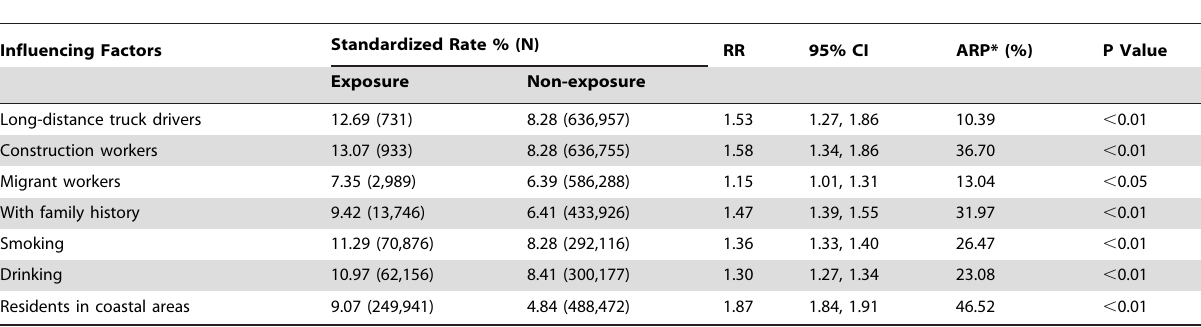
Table 2. Factors influencing HBsAg carrier rate for ages 20 to 60